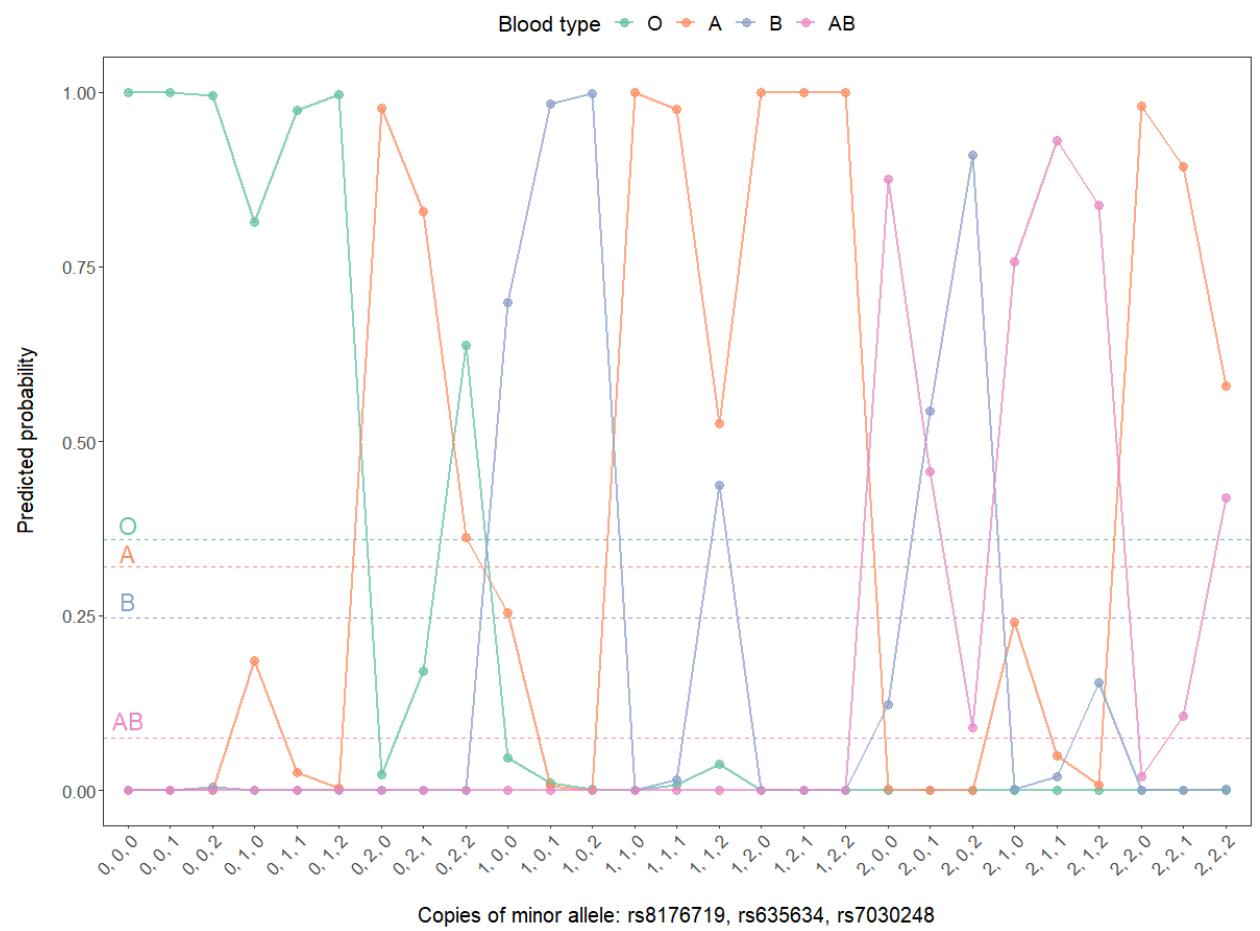
Figure 4. Predicted probabilities of ABO blood types based on the combined set of rs8176719 , rs635634 and rs7030248 in the multinomial model. The dashed horizontal lines annotate the prevalence of respective ABO blood types in the cohort. Note: due to the limited sample size and the factor of minor allele frequency, not all allele combinations (3 3 = 27) of the three SNPs are represented in the cohort (the 16 combinations represented are tabulated in Table S10; the other 11 combinations are not present in the cohort, so the prediction of ABO blood types for these genotype sets could not be evaluated for prediction performances).